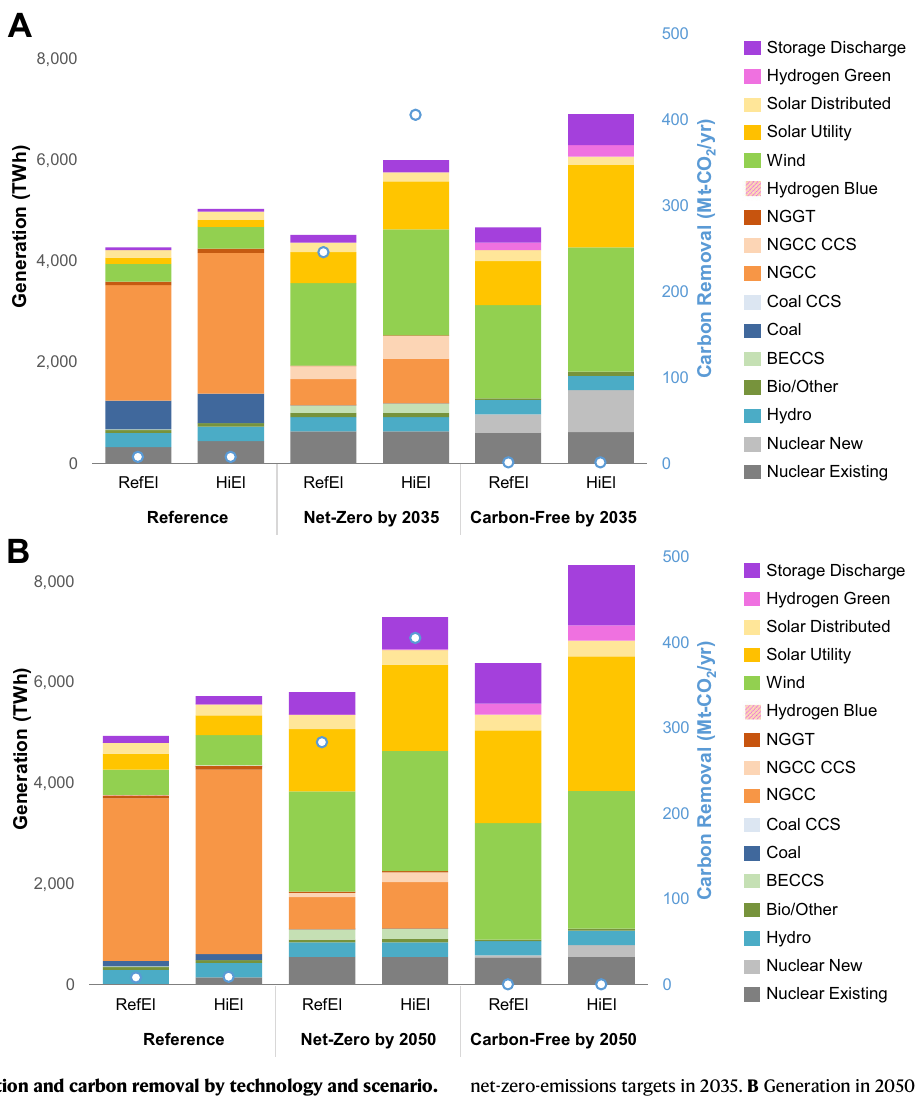
net-zero-emissions targets in 2035. B Generation in 2050 assuming net-zero- emissions targetsin 2050.NGGTnaturalgasturbines, NGCCnaturalgascombined cycle, CCS carbon capture and sequestration, BECCS bioenergy with